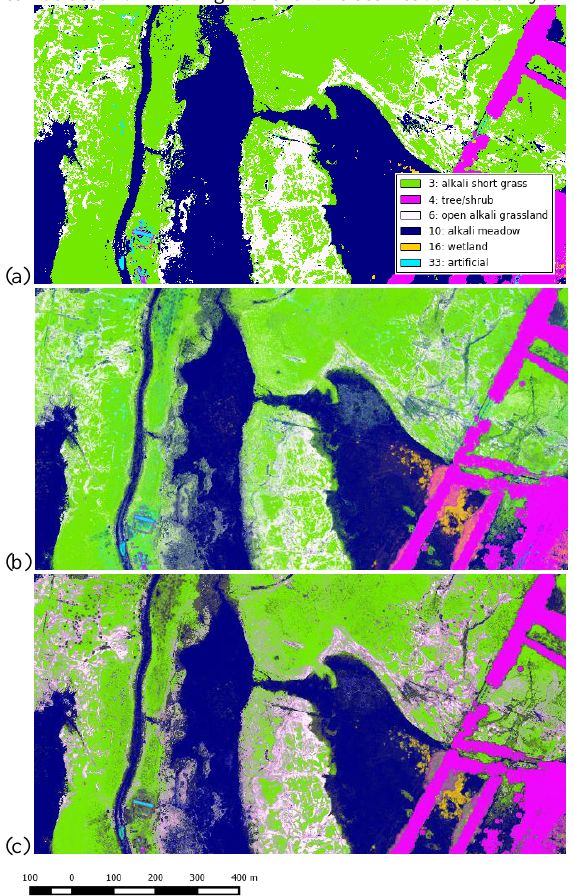
Figure 1. Classified vegetation map: hard-boundary (a), fuzzy blended in RGB (b), fuzzy blended using hue-preserving algorithm (c). The same colour scheme is used throughout